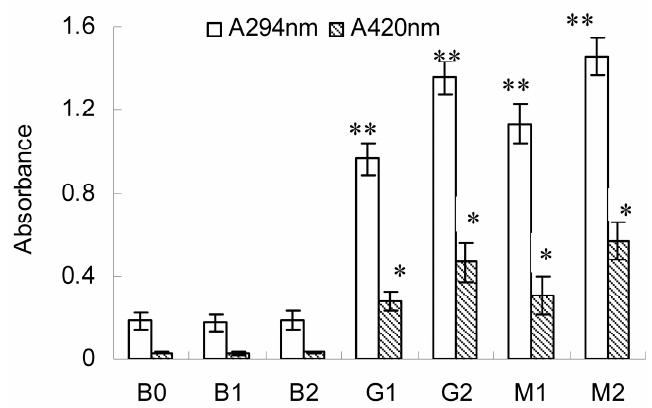
Figure 1. Absorbance measured at 294 and 420 nm of BSA, BSA–glucose and BSA–mannose at intensities 10 and 20 kV/cm. Data are mean ± standard deviation, n = 3. * p < 0.05, ** p < 0.01 versus control (B0).